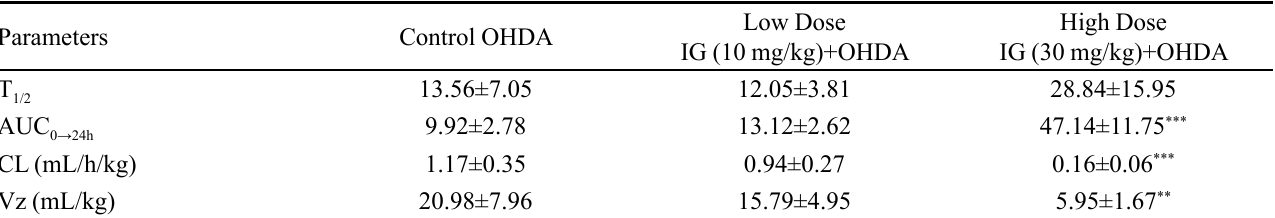
TABLE III - Comparison of pharmacokinetics parameters of 4 hydroxy diclofenac in the presence of iguratimod Parameters